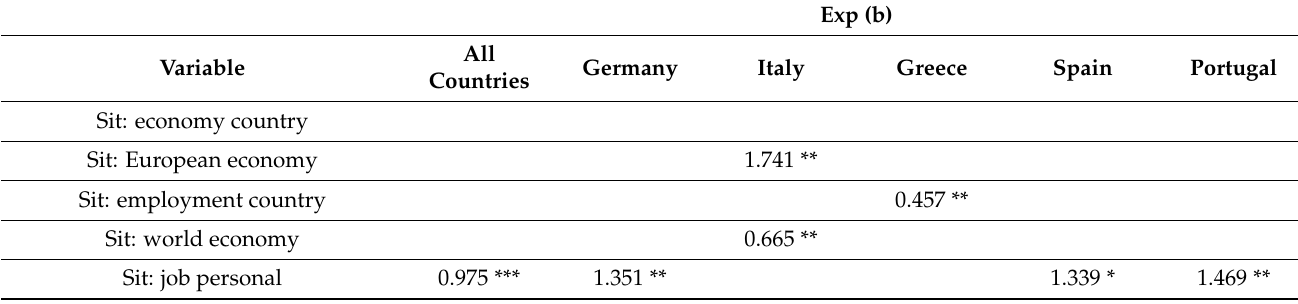
Table 6. Impact of economic factors on national attachment: Germany, Spain, Italy, Greece, and Portugal (2012). VD: 0, not very attached; 1, very attached. Source is authors’ own elaboration based on EB 77.3. p values: * ≤ 0.05, ** ≤ 0.01, *** ≤